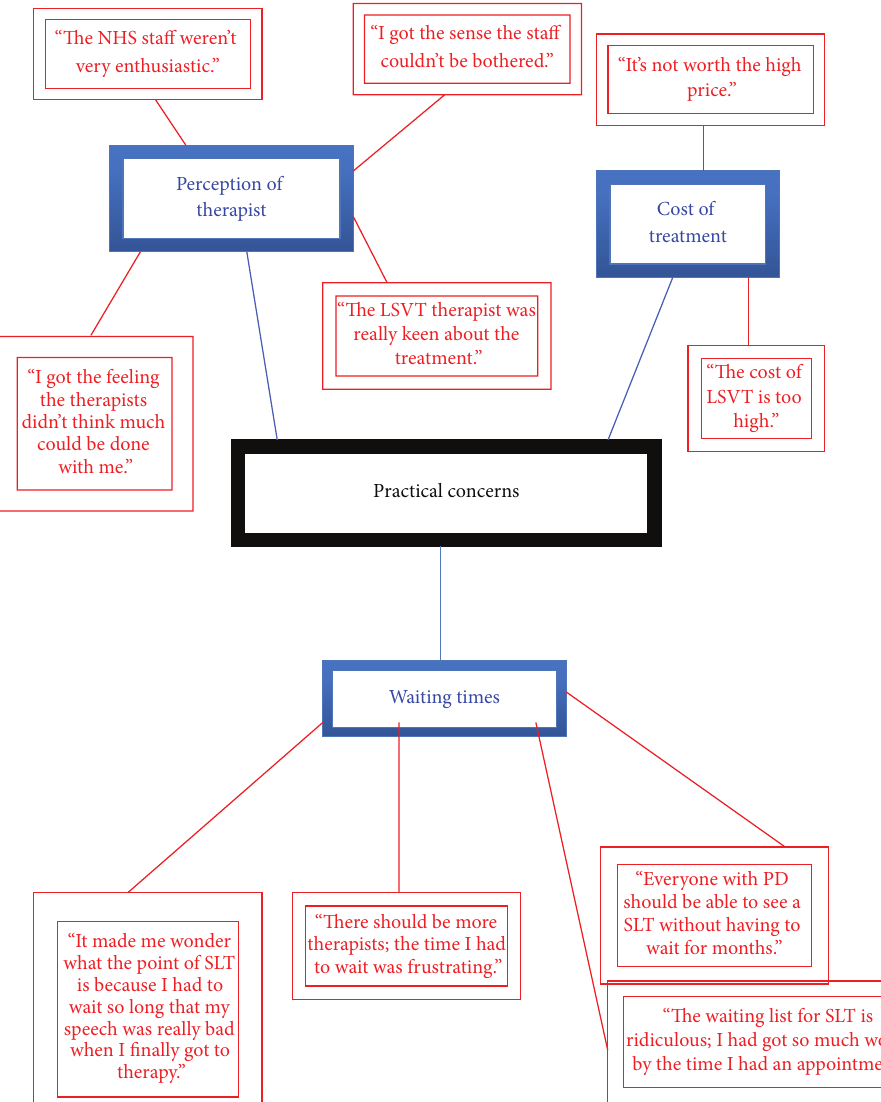
Figure 3: Thematic Network Analysis: practical